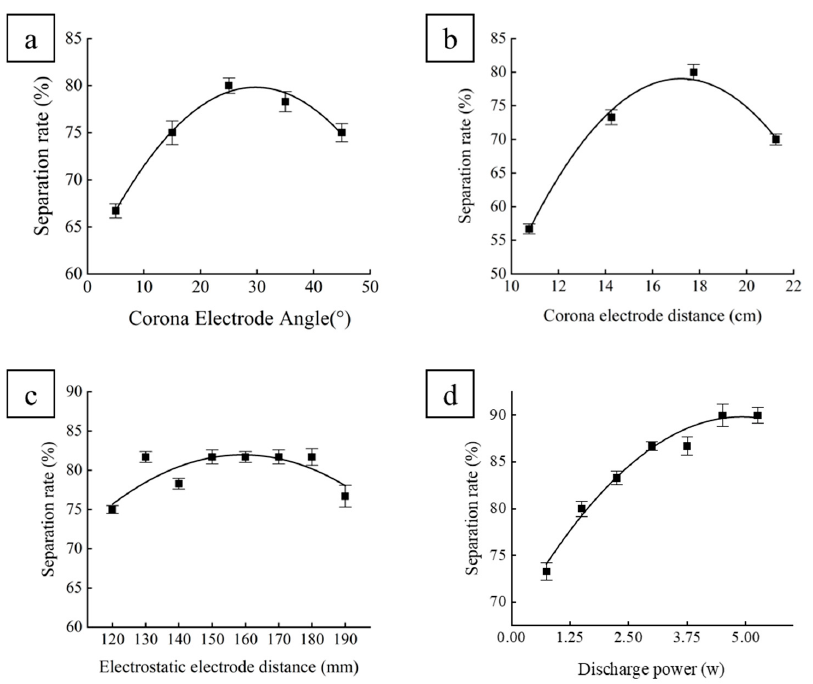
Figure 7. Relationships between the separation efficiency and the electrode position and other op- erating parameters. ating parameters. ( a ). Relationship between corona electrode angle and residual film separation rate, ( b ). Relationship between corona electrode distance and residual film separation rate, ( c ). Relationship between the electrostatic electrode position and the residual film separation rate, ( d ). Relationship between discharge power and separation